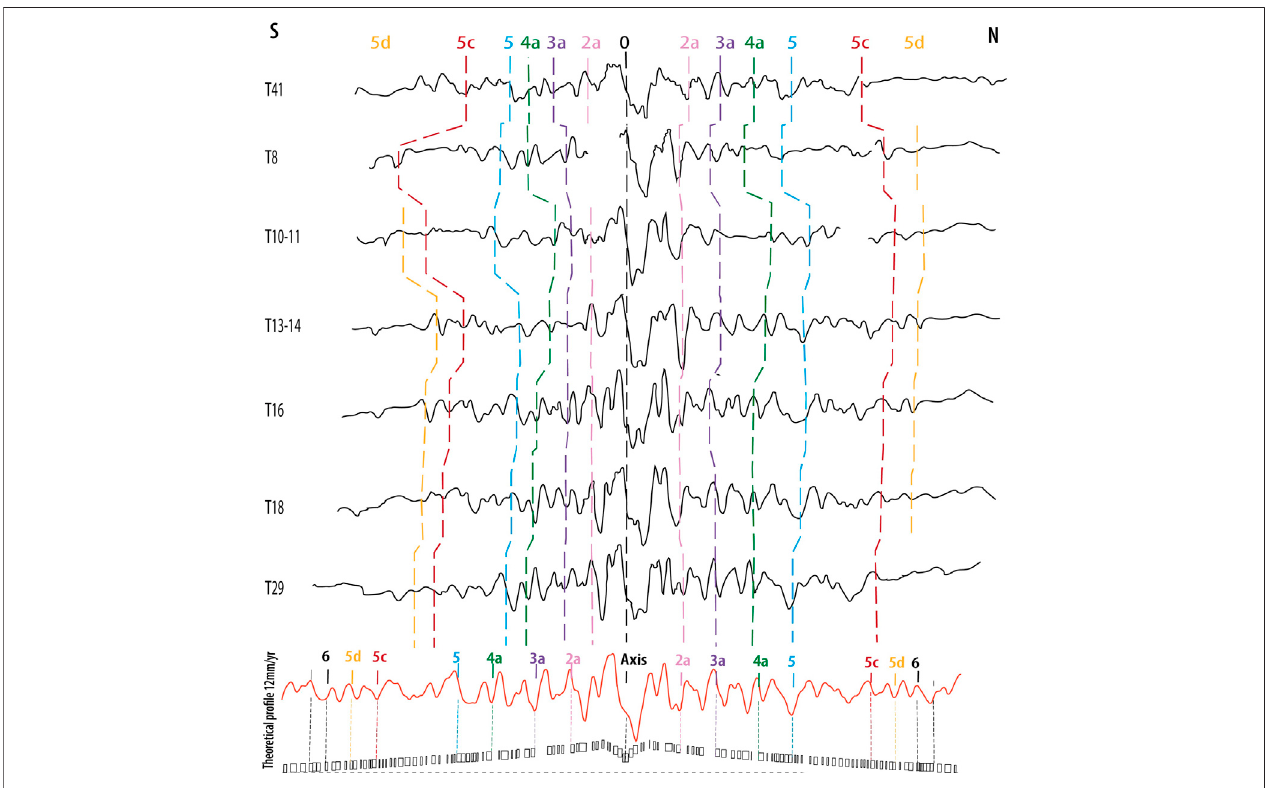
FIGURE 4 | Magnetic anomaly pro fi les corresponding to seismic transects shown in Figure 2 . Anomaly identi fi cations are based on the synthetic model shown in redbelowthepro fi les.Themodelwascalculatedwithasymmetricalhalfrateof12 mm/yr,whichemphasizestheasymmetryofspreadingalongthesegment:spreading on the southern fl ank has been signi fi cantly slower than on the northern fl ank.